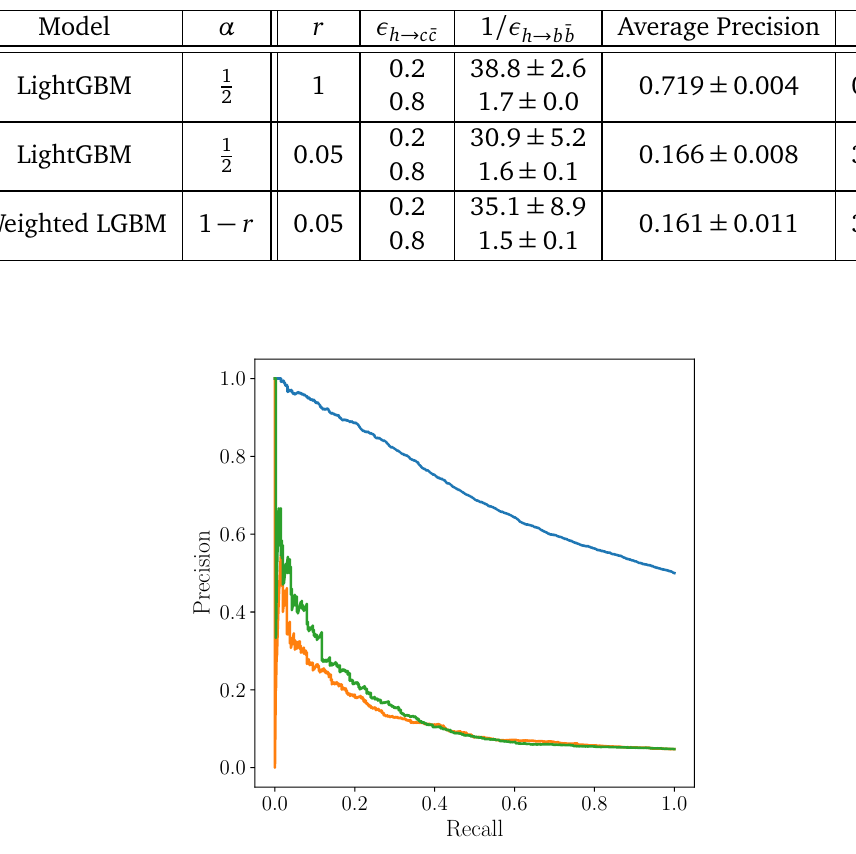
Figure 4: The precision-recall curves for our three h → c ¯ c tagging tests. The blue, or- ange, and green curves correspond to the test results in the top, middle, and bottom rows of Table 2, respectively. These curves provide another way of demonstrating that the weighted LGBM outperforms (green) outperforms it unweighted counter- part (orange). Specifically, at lower recall, weight the loss function to remove class imbalance leads to a gain in performance. Recall is equivalent to true position rate or signal efficiency, ε h → c ¯ c